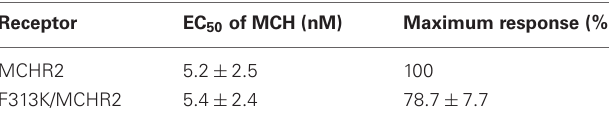
FIGURE 5 | Effects on receptor activity of substitution mutations of the residues adjacent to Phe318 in HEK293T cells. (A) Sequences of Flag-MCHR1 and three mutants for which native residues were replaced with Lys (E316K, T317K and R319K/R321K). (B) Dose-response relationship of MCH-stimulated calcium influx in HEK293T cells expressing Flag-MCHR1 or substitution mutant receptors. Cells transfected with Flag-MCHR1 or substitution mutant receptors were stimulated with the indicated concentrations of MCH, and the subsequent changes in cytoplasmic free Ca 2 + levels were measured using a FlexStation. Results shown are representative of at least three-independentexperiments. Table 4 | Signaling of human MCHR2 and its single-substitution (F313K) mutant after transfection into HEK293T